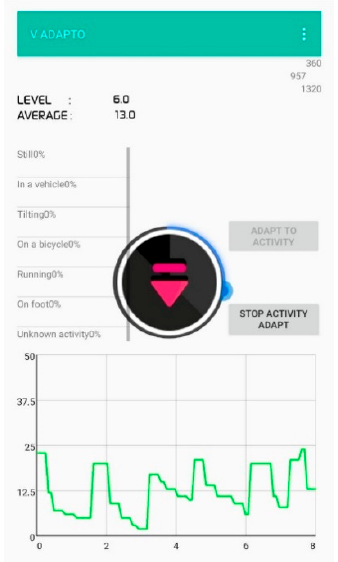
Figure 14. Average level below 20.